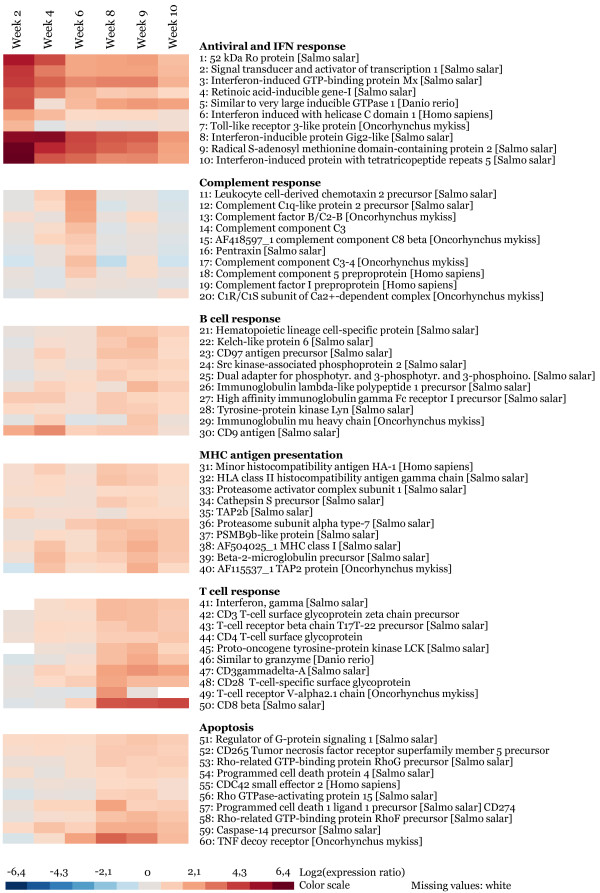
Temporal regulation of representative genes. Heat map showing the temporal expression of ten selected genes from each immune pathway (gene set) from Figure 4, as referred to in the Results section. Data are mean log2-ER of replicate pools of heart tissues from the six time points (2 to 10 wpi). Graded levels from gray to red indicate upregulation, and graded levels from gray to blue indicate downregulation. The scale of the colors is shown at the bottom of the figure.